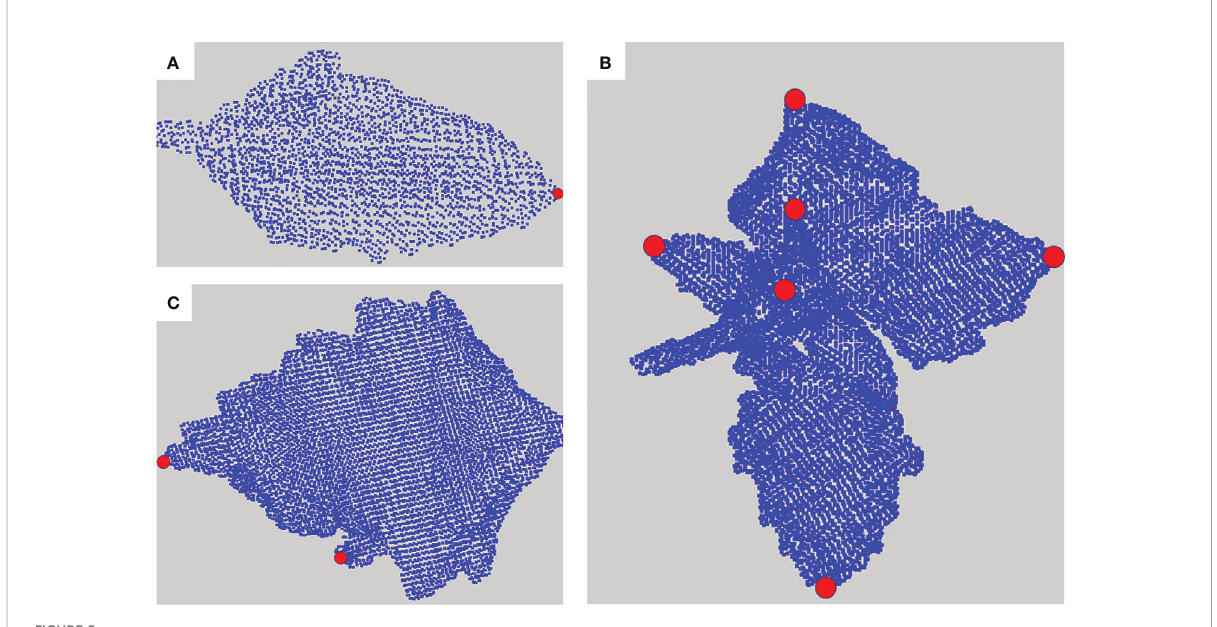
FIGURE 5 Locally extremal values for the Fiedler eigenvector on three different organs represented by red dots. (A) A simple leaf blade, (B) an apex and (C) a serrated leaf